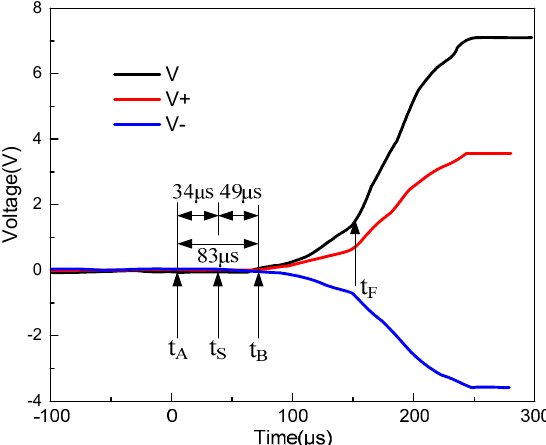
Figure 10. Three characteristic time domains of voltage signal changes.